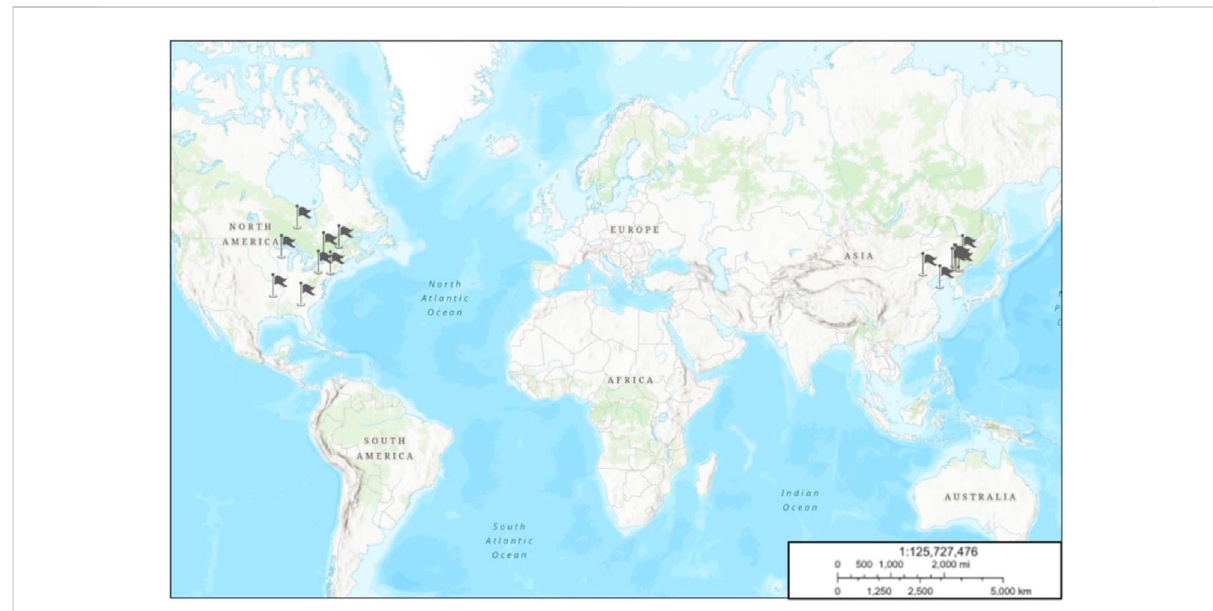
FIGURE 1 Geographical distribution of P. quinquefolius based on GMPGIS. The map was plotted using online ArcGIS (ESRI, Redland, CA, United States. URL: http://www.learngis2.maps.arcgis.com/). Flags showing cultivated or wild resources of P. quinquefolius .